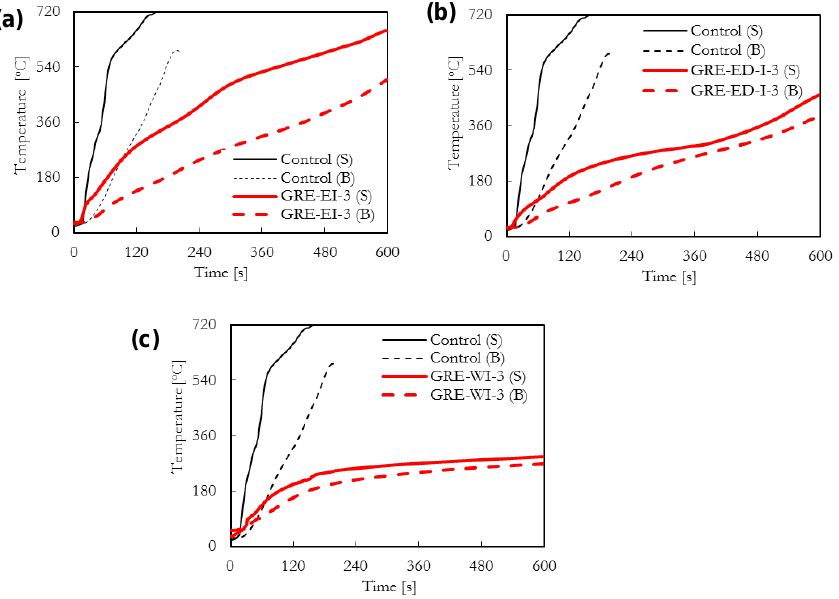
Figure 5. The surface and back surface temperatures vs. time for control and ( a ) EI, ( b ) ED-I and ( c ) WI coated (coating thickness = 3mm) samples at 50 kW/m 2.